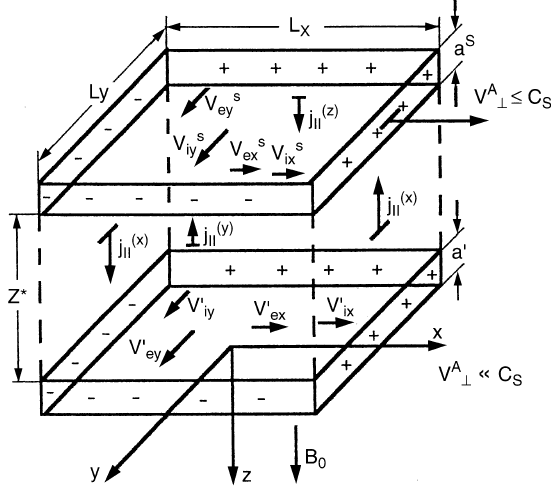
Fig. 3. Schematic picture of the model E s generator– E s load. The neutral wind acts on the upper layer ( E s generator) and does not act on the lower layer ( E s load). In the lower layer rather large electron velocity drifts